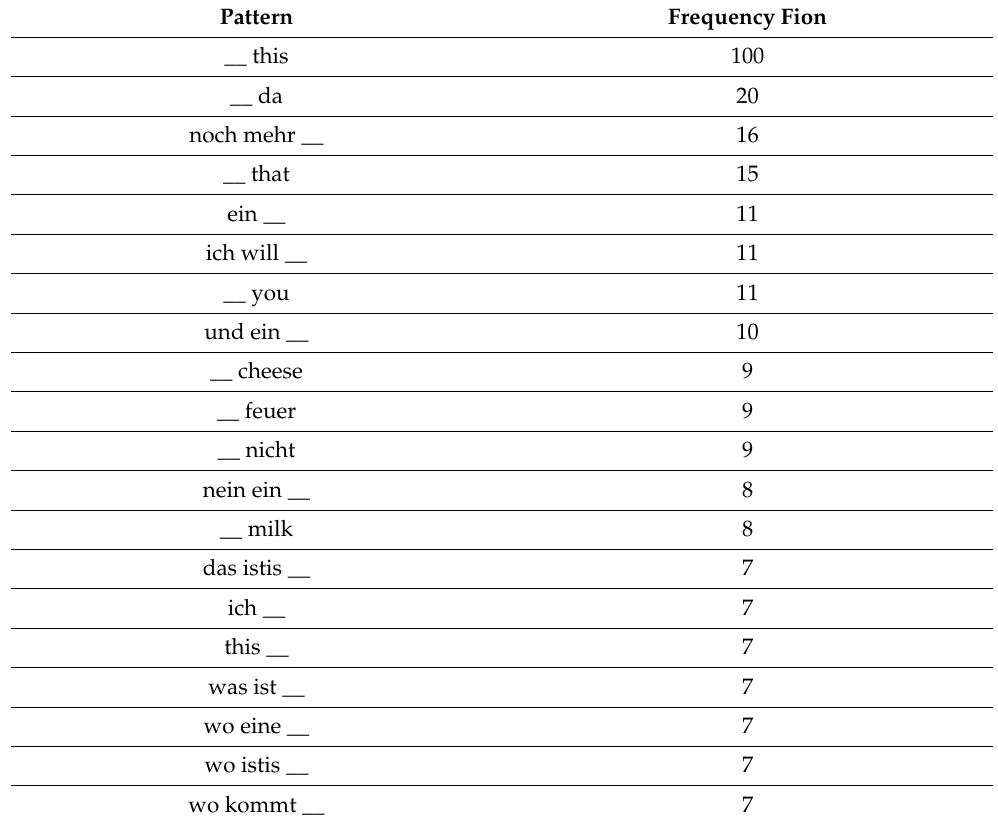
Table 1. Most frequently attested patterns in the Fion data according to the TB method, from Quick and Hartmann